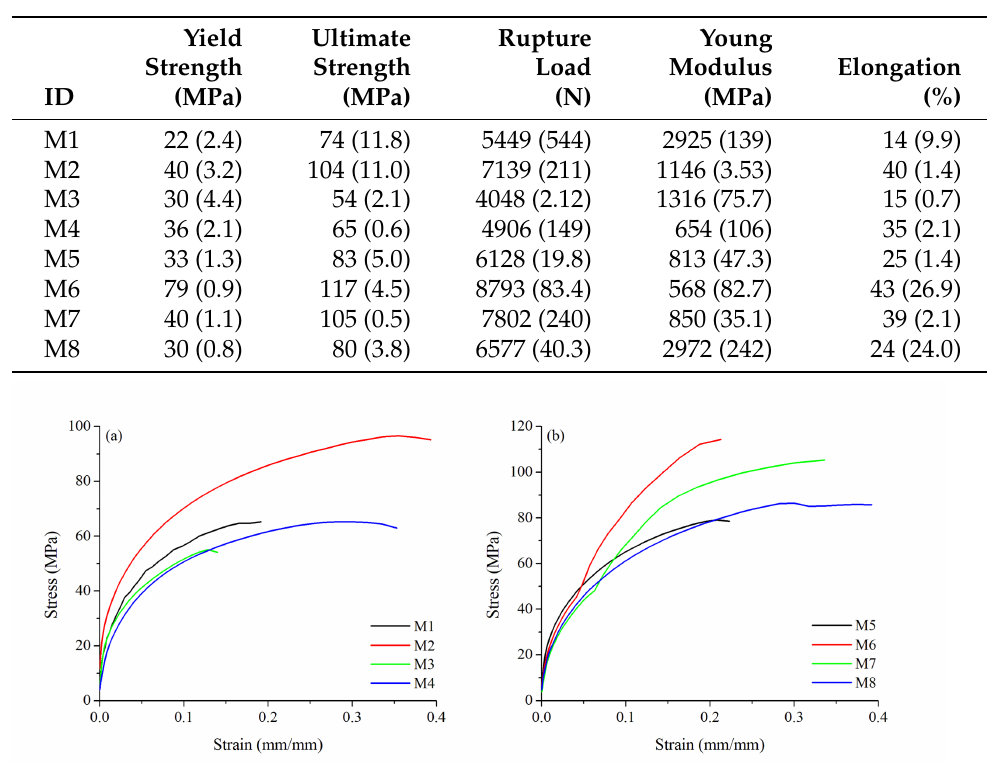
Table 3. Mechanical properties from the tensile test of welded samples. SD in parenthesis.